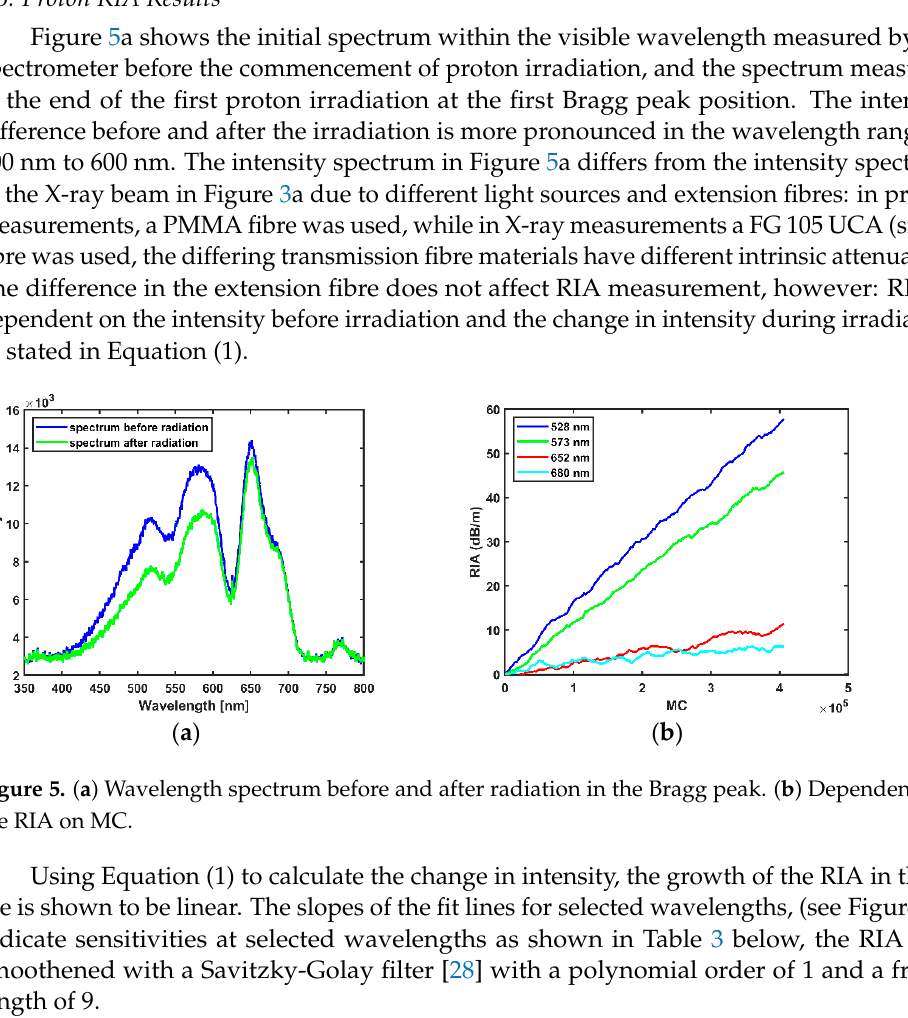
Table 3. Sensitivity of INO fibre at Bragg wavelength for fibre irradiated with proton beam.